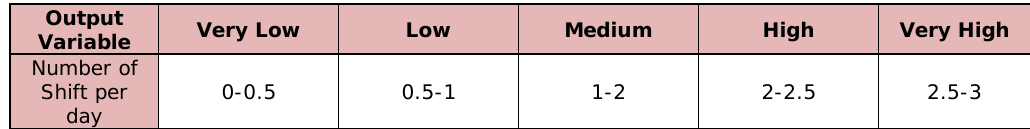
Table 2. “Variation of output linguistic variables”. Source: Own